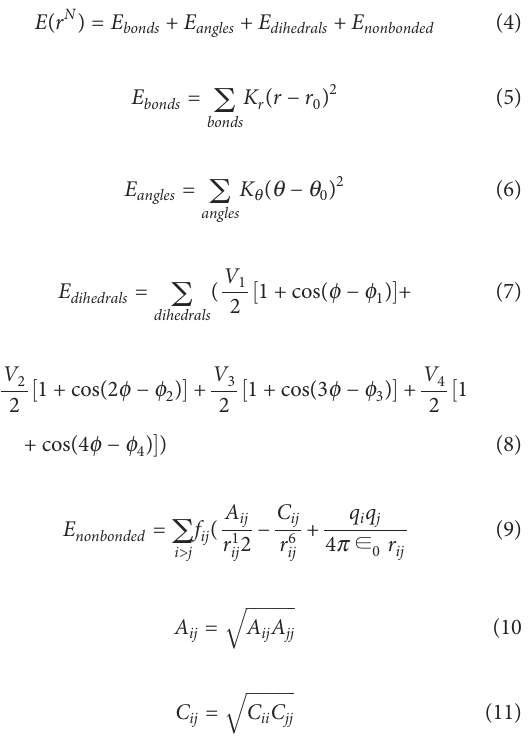
Equation 2. OPLS Force Field Formula (adapted from Jorgensen et al.) for Electrical Field Across Protein